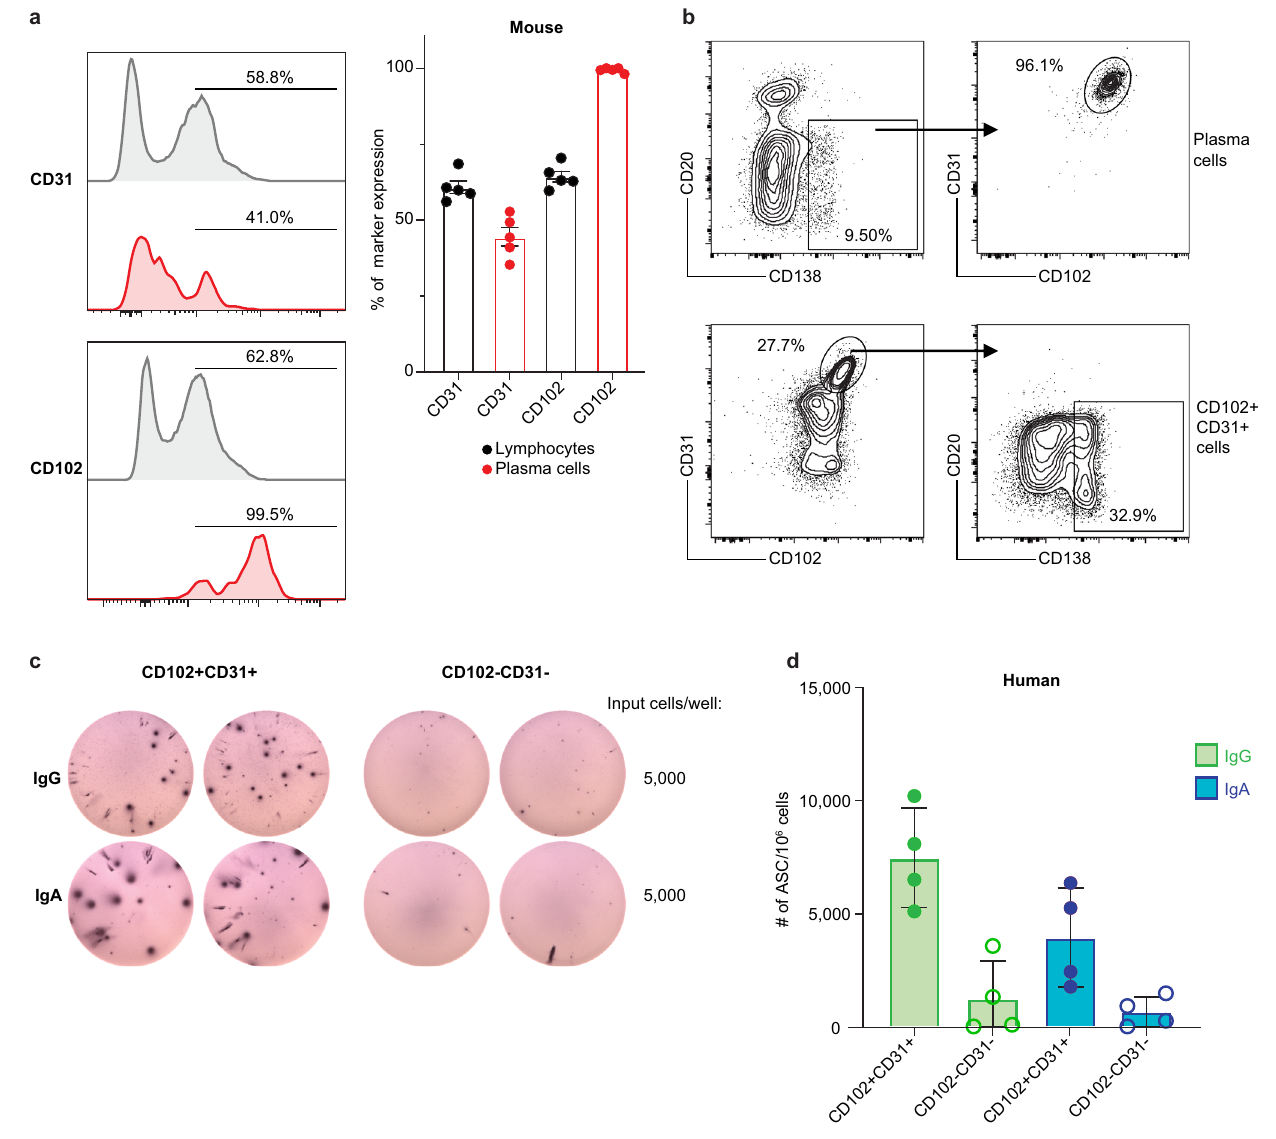
Fig. 5 CD102 and CD31 expression is conserved across species. a Left panel: Representative histograms of CD31 and CD102 expression on bulk lymphocytes or CD138 + plasma cells on cells from mouse bone marrow. CD138 + plasma cells were previously gated as live, singlets, CD4 − CD8 − F4/ 80 − NK1.1 − IgD − . Lymphocytes were previously gated as live singlets. Right panel: Quanti fi cation of CD31 and CD102 expression on bulk lymphocytes or CD138 + plasma cells on cells from mouse bone marrow. Error bars represent standard error of the mean. n = 5 biologically independent animals. b Top panel: Representative fl ow plot of plasma cell gates and CD102 and CD31 expression on plasma cells from human bone marrow cells. Bottom panel: Representative fl ow plot of frequency of plasma cells within CD102 + CD31 + cells. c Representative images of ELISPOT wells coated with either anti-IgG or anti-IgA. CD102 + CD31 + or CD102 − CD31 − cells from human bone marrow were plated in duplicate and serial diluted (2-fold) down the plate. Loadings for the top dilution are indicated. d Quanti fi cation of ELISPOT results depicting the number of ASCs identi fi ed per million input cells for both total- IgG and total-IgA secreting cells. Error bars represent standard deviation from the mean. n = 4 biologically independent human